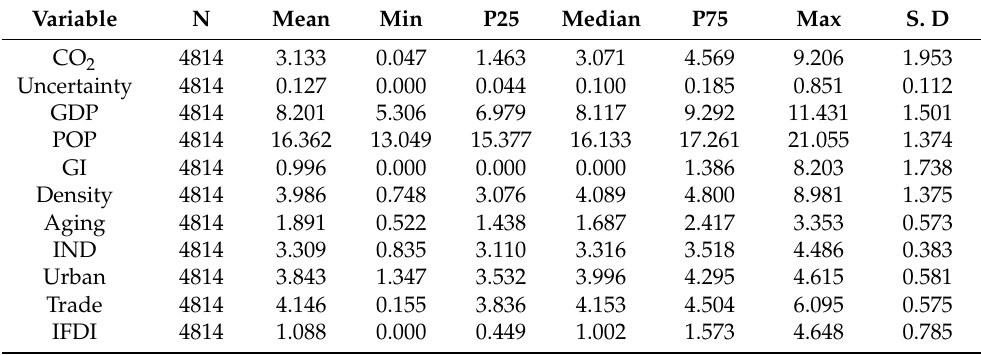
Table 2. Summary of descriptive